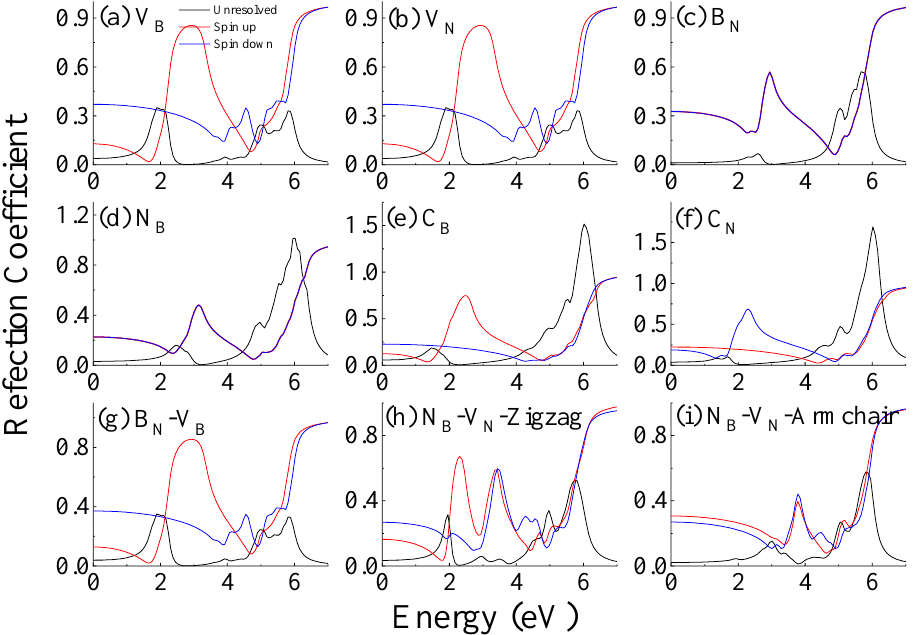
Figure 5. Reflection spectra of hBN supercell with the various defects of ( a ) V B , ( b ) V N , ( c ) B N , ( d ) N B , ( e ) C B , ( f ) C N , ( g ) B N -V B , and ( h ) N B -V N in a zigzag direction, and ( i ) N B -V N in an armchair direction. The black, red, and blue lines indicate the spin-unresolved ( × 10), -up, and -down reflection spectra. The structural stability of the hBN monolayer with different defects was analyzed with the formation energy of the localized single defect within the supercell of 4 × 4 unit cells. Figure 6 displays the phonon band structure of the monolayer with the defects. It was found that only the hBN monolayer with the N B -V N defect demonstrated the imaginary vibrational mode that implies the structural